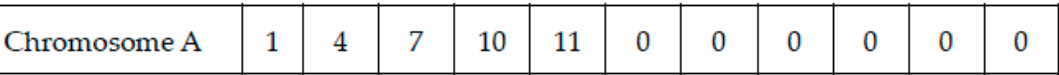
Figure 2. Simple taxiway network diagram.